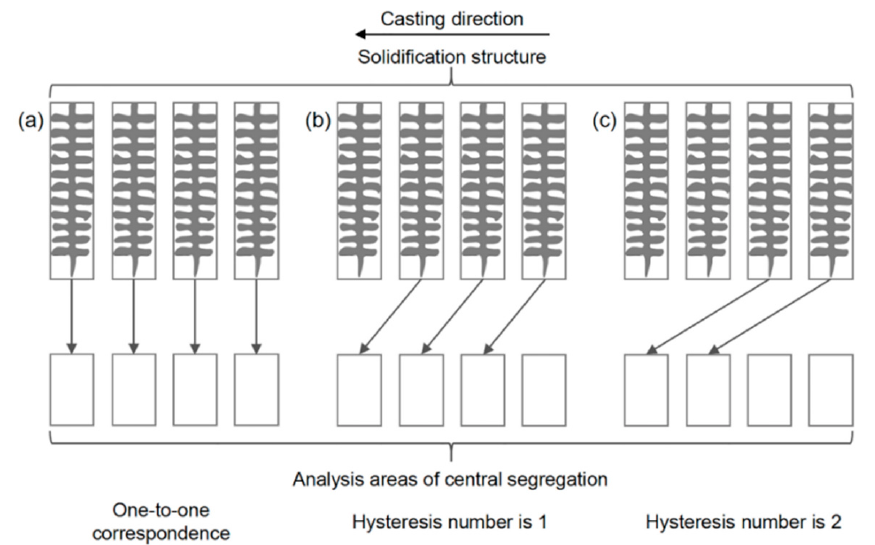
Figure 7. Hysteretic treatment of solidification structure and central segregation. The central analysis area and the solidification structure correspond to each other is as shown in ( a ). When the central segregation in the analysis area is affected by the position where the hysteresis number is 1, the corresponding relationship is shown in ( b ). When the central segregation in the analysis area is affected by the position where the hysteresis number is 2, the corresponding relationship is shown in ( c ).